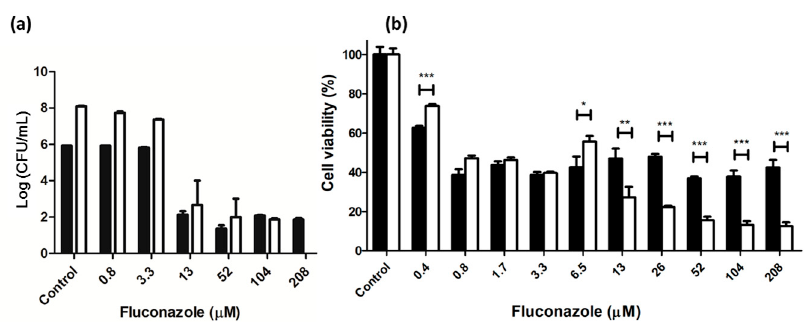
Figure 2. Viability of C. albicans in ( a ) planktonic culture and ( b ) adherent culture after treatment with fluconazole. The filled and unfilled columns represent treatments for 24 h and 48 h, respectively. * p < 0.05, ** p < 0.01, *** p < 0.001.